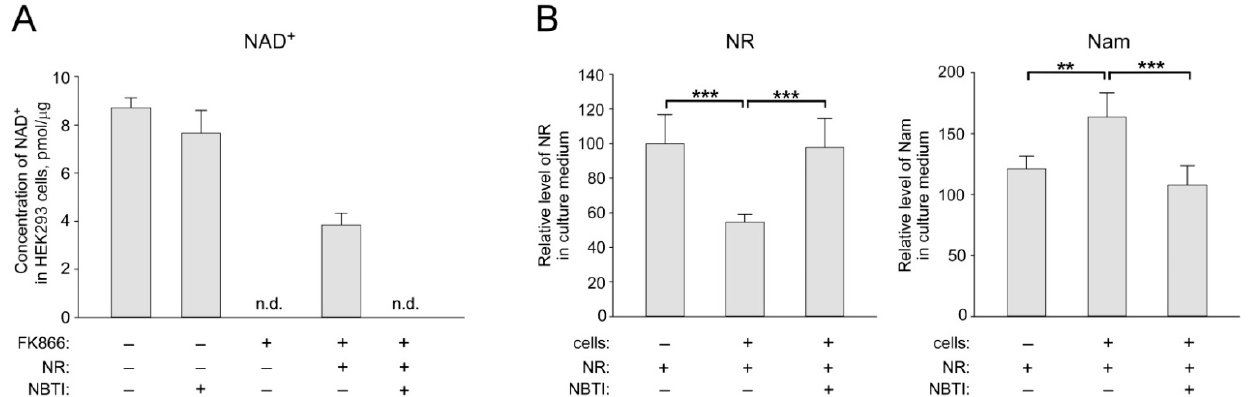
Figure 1. The effect of equilibrative nucleoside transporter (ENT) inhibition on NR utilization by HEK293 cells for NAD + biosynthesis. HEK293 cells were cultivated in Dulbecco’s modified Eagle’s medium (DMEM) containing Nam, supplemented with 10% fetal bovine serum (FBS). Cells were treated with nicotinamide riboside (NR) (100 µ M) and inhibitor of equilibrative nucleoside transporters S-(4-nitrobenzyl)-6-thioinosine (NBTI) (10 µ M) as indicated. To inhibit NAD + synthesis from Nam, cells were treated with FK866 (2 µ M) ( A ). Twenty-four hours after the treatment, cell extracts ( A ) and culture medium ( B ) were analyzed by quantitative NMR spectroscopy. ( A ) The concentration of intracellular NAD + is expressed in picomoles per microgram of total protein in cell extract. Data are presented as mean ± S.D. n.d.—not detected. ( B ) Relative levels of NR and Nam in culture medium are presented. Amount of NR in control culture medium incubated without cells was taken as 100. Data are presented as mean ± S.D ( n = 3). Statistical analysis of differences between the groups was carried out by one-way ANOVA with post hoc comparisons using Tukey test. ** indicates statistical significance at p < 0.01, *** indicates statistical significance at p < 0.001.